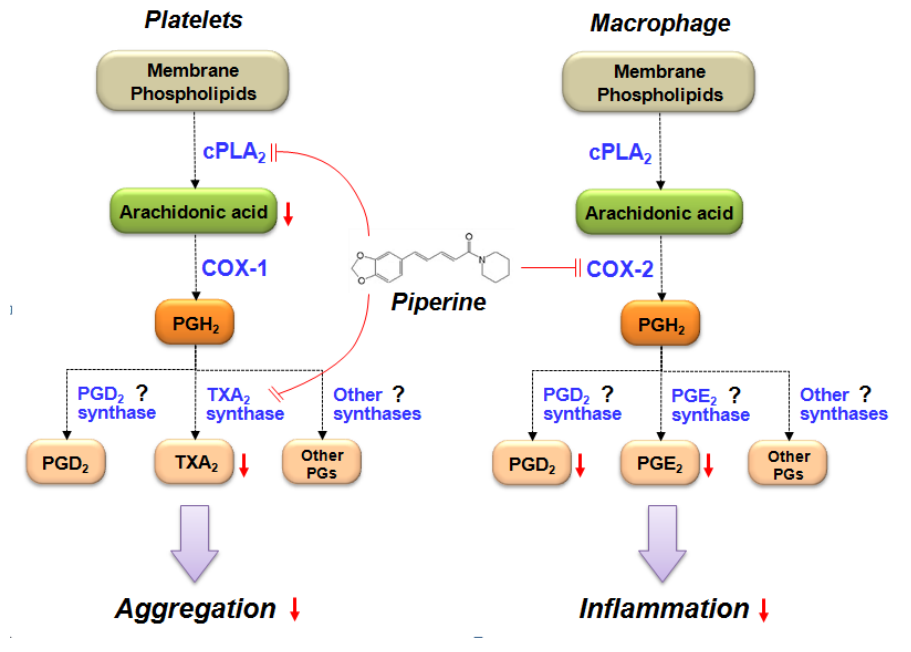
Figure 6. Scheme of the proposed mechanism by which piperine inhibits platelet aggregation and macrophage inflammatory processes. This study demonstrated that piperine (Figure 1a) inhibits both platelet aggregation (Figure 1b) and macrophage inflammatory responses (Figure 2). Treatment with piperine was shown to suppress AA liberation (Figure 3a) through the inhibition of cPLA activity (Figure 4a) in platelets, but not in macrophages 2 (Figures 3b and 4b). Additionally, piperine inhibits the activities of TXA synthase 2 (Figure 4c) and COX-2 (Figure 5c,d), but not COX-1 (Figure 5a,b). Piperine inhibits cPLA 2 activities, suppressing platelet aggregation through decreased TXA generation. and TXA 2 2 Piperine-dependent inhibition of COX-2 activity results in a suppression of the macrophage inflammatory response through decreased prostaglandin